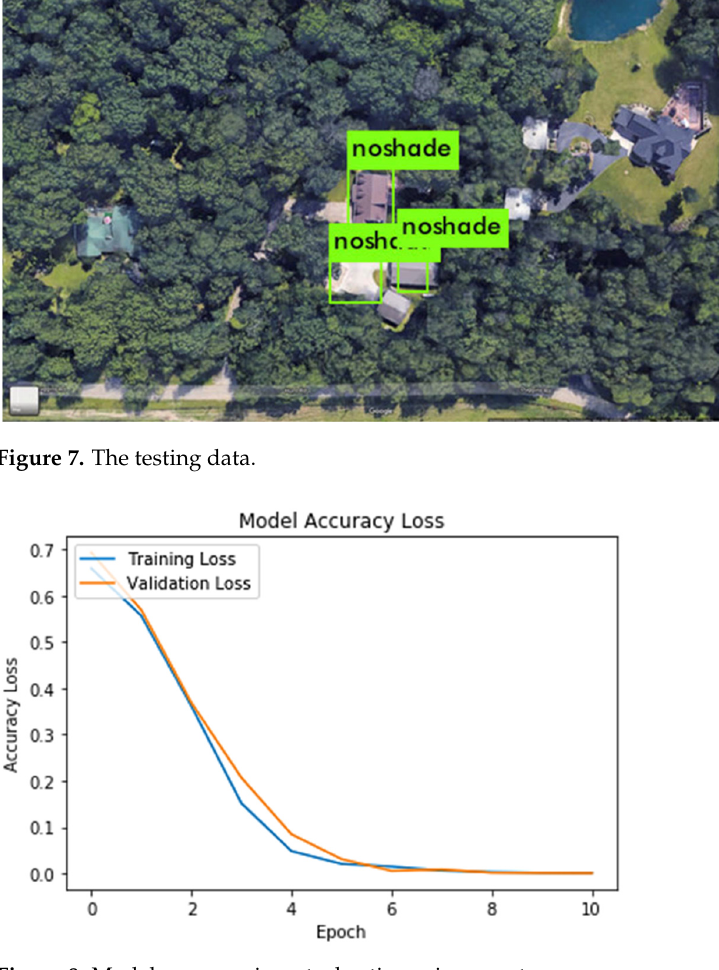
Figure 8. Model accuracy in a stochastic environment.